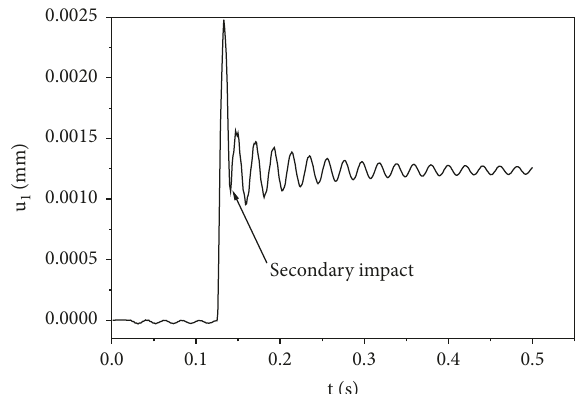
Figure 14: Displacement time history curve when E